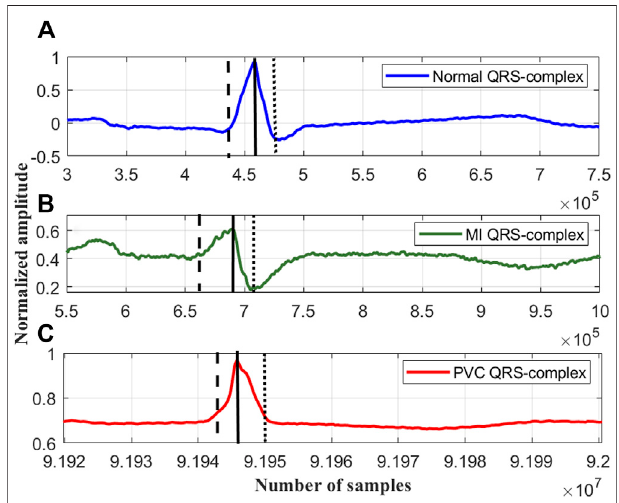
FIGURE3| TheriseandfalltimesoftheQRS-complexesofa (A) normal ECG beat, lead I; record #s0273lrem, PTBDB, (B) myocardial infraction (MI) ECG beat, lead I; record #s0015lrem, PTBDB and (C) premature ventricular contraction (PVC) beat, lead V5; record # 104m, MITDB.